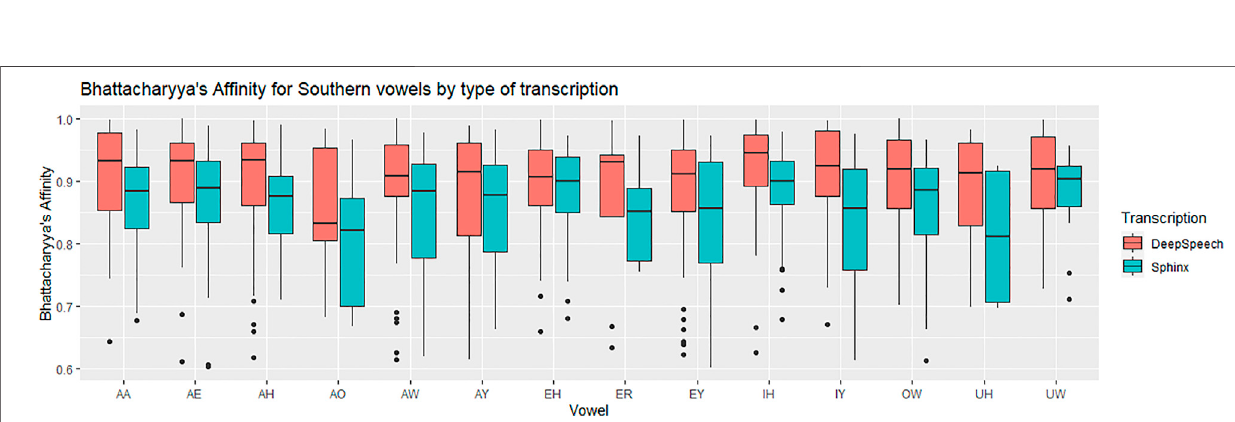
Frontiers in Arti fi cial Intelligence |